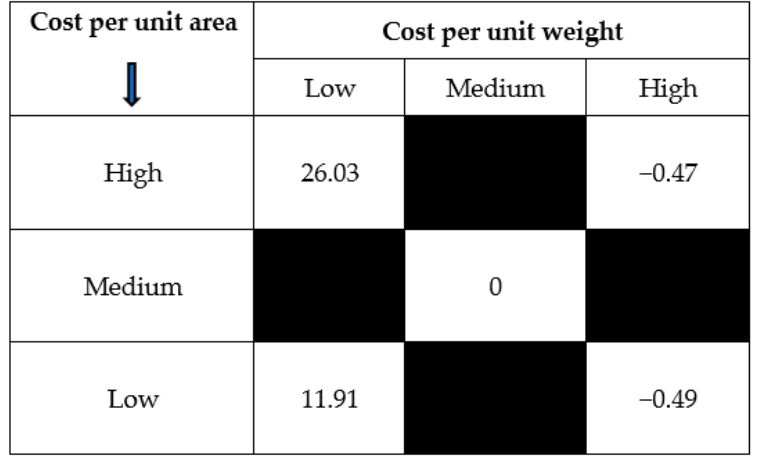
Figure 3. Variations in inventory holding costs of Organization B.